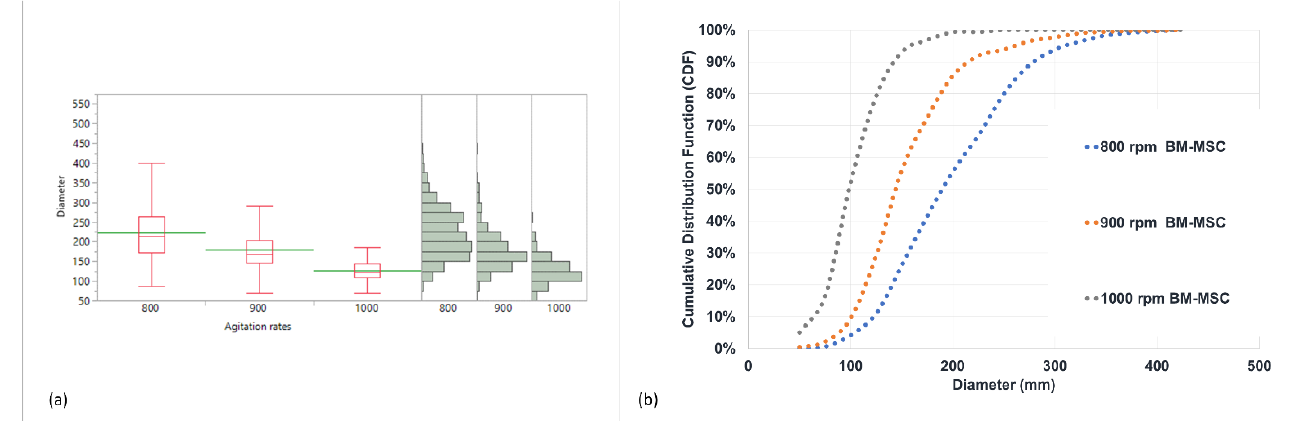
Figure 1. Characterization of alginate beads: ( a ) size distributions of hBM-MSC-loaded alginate beads formed at agitation rates of 800, 900, or 1000 rpm; and ( b ) corresponding cumulative-distribution-function (CDF) plot of bead diameter at different agitation rates.